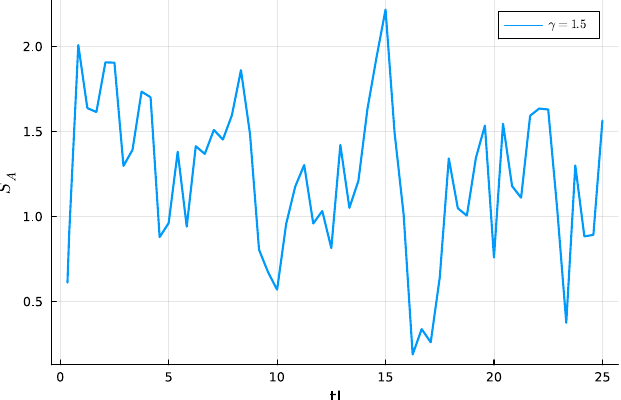
= 6, and the number of bosons s